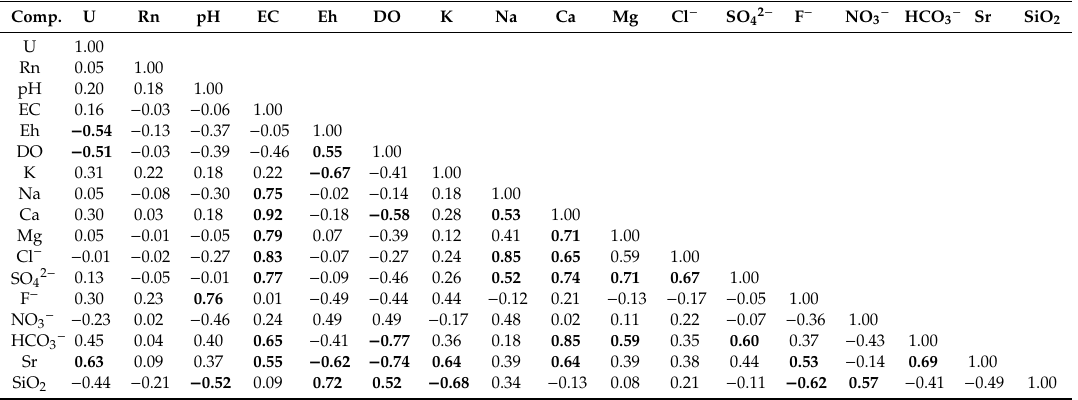
Table 2. Correlation matrix for hydrogeological components in groundwater. Bold values indicate moderate to strong correlation coe ffi cients ( − 0.50 < or > 0.50). comp: